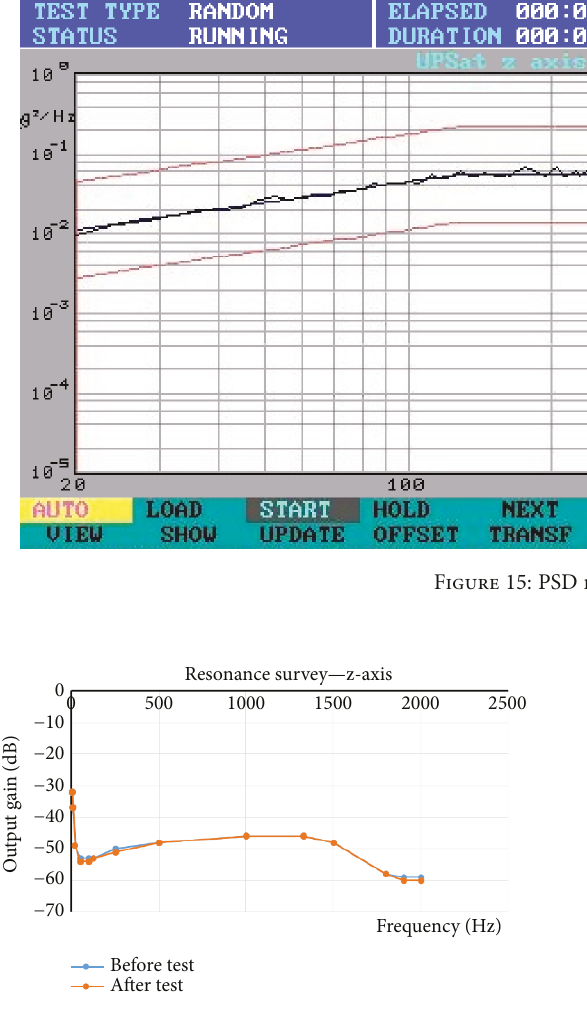
Figure 16: z -axis response and resonance test.